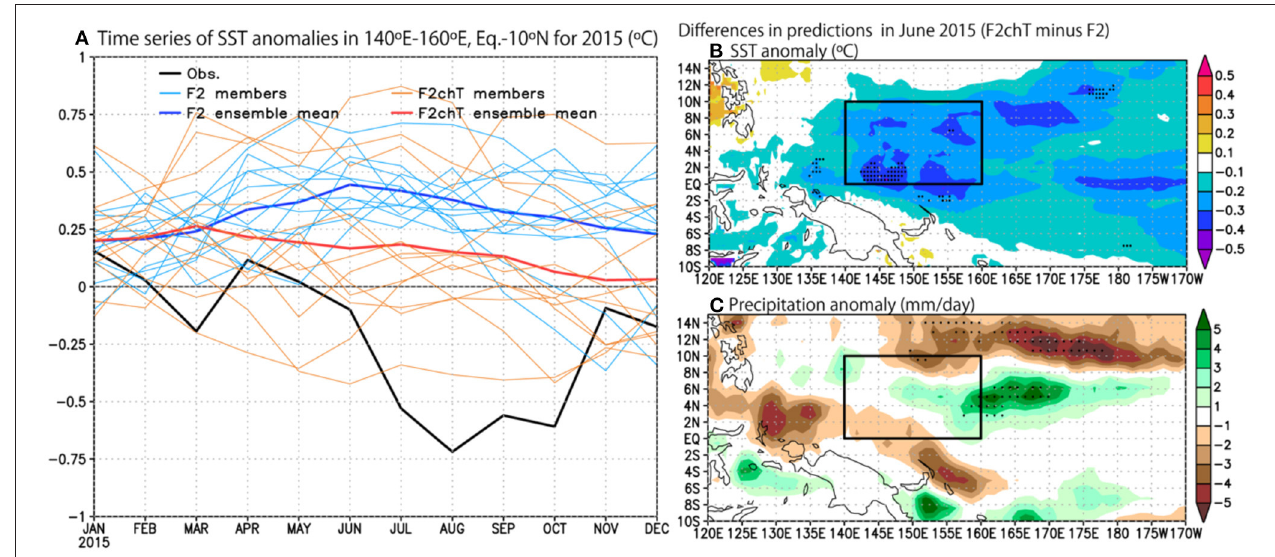
FIGURE 4 | (A) Monthly time series of the SST in 140 ◦ E − 160 ◦ E, equator − 10 ◦ N ( ◦ C) from the observational data (black) and the predictions issued on January 1 st , 2015 by F2 (12-ensemble mean: blue, individual members: right blue) and F2chT (12-ensemble mean: red, individual members: orange). (B) A horizontal map of differences in the ensemble mean predictions of SST anomalies ( ◦ C) in June 2015 (F2chT minus F2). Black dots indicate the statistically significant difference in the ensemble means between F2 and F2chT beyond the 90% confidence levels on paired t -test. (C) Same as (B) , but for precipitation (mm/day − 1 ).